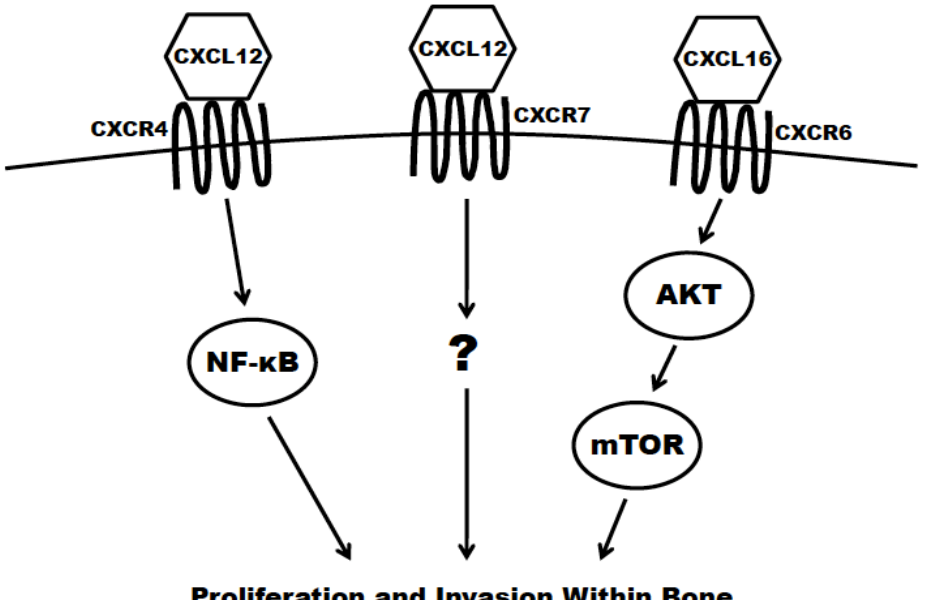
Figure 2. Cytokine signaling through their cognate receptors results in promotion of prostate cancer metastasis formation in the bone (Prepared by author Robert J.